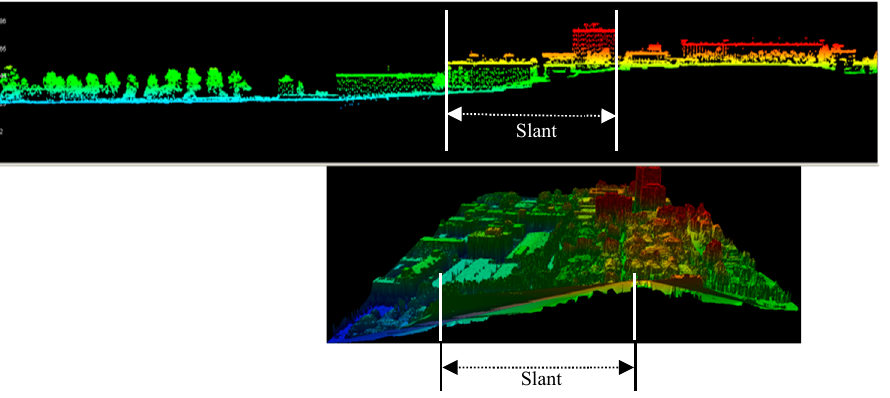
Figure 3. University of New South Wales (UNSW) airborne lidar data set and representation of slant area in a profile view and a 3D view.